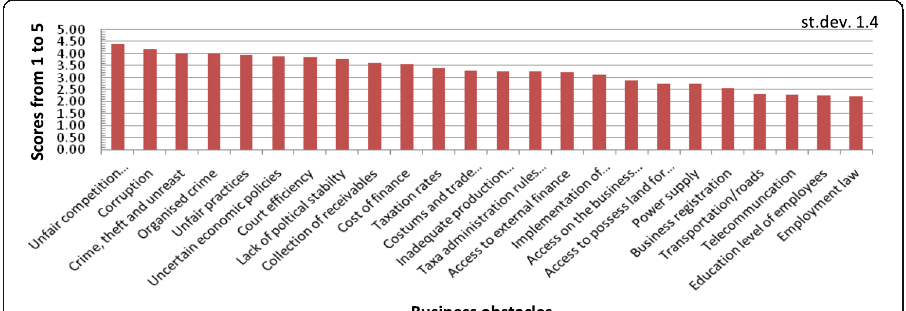
Fig. 3 Ranking of constraints on business environment as per perception of firm managers. Source: Riinvest Survey,